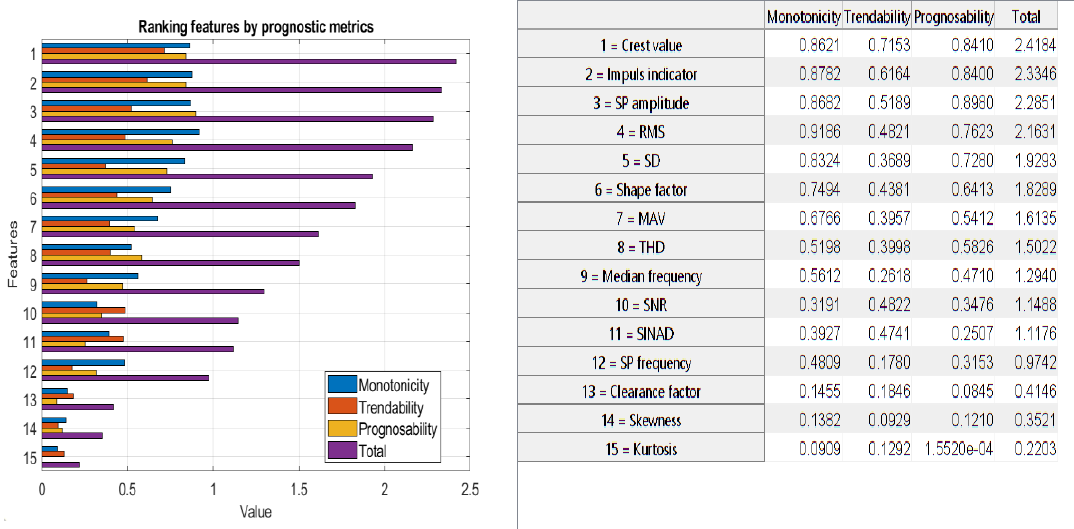
Table 6. Assessing the impact of diagnostic features on prediction performance. The first model uses all extracted features, Model 2 and Model 3 are use the features with total score higher than 1 and 1.5 respectively as training input.